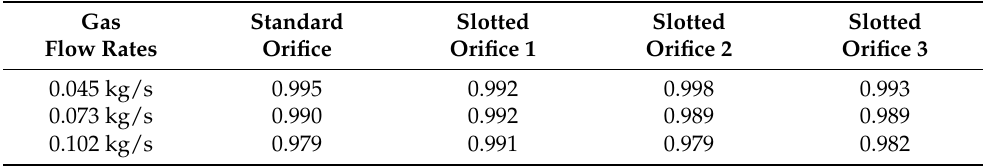
Table 2. Values of expansion factor for investigated orifices ε .